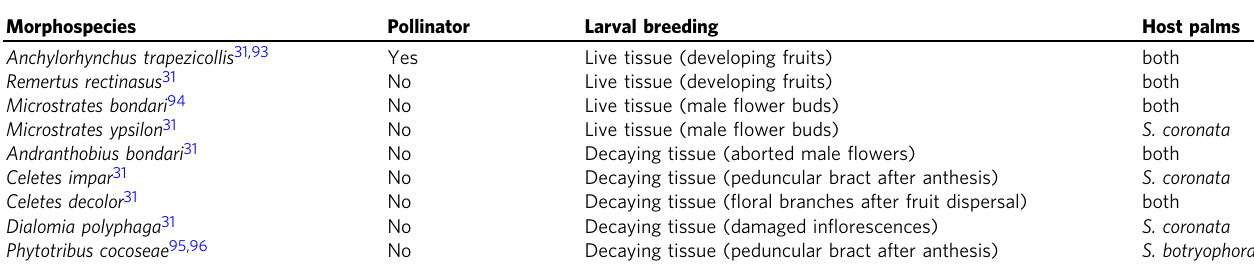
Table 1 Weevil morphospecies included in the study with references for natural history information.